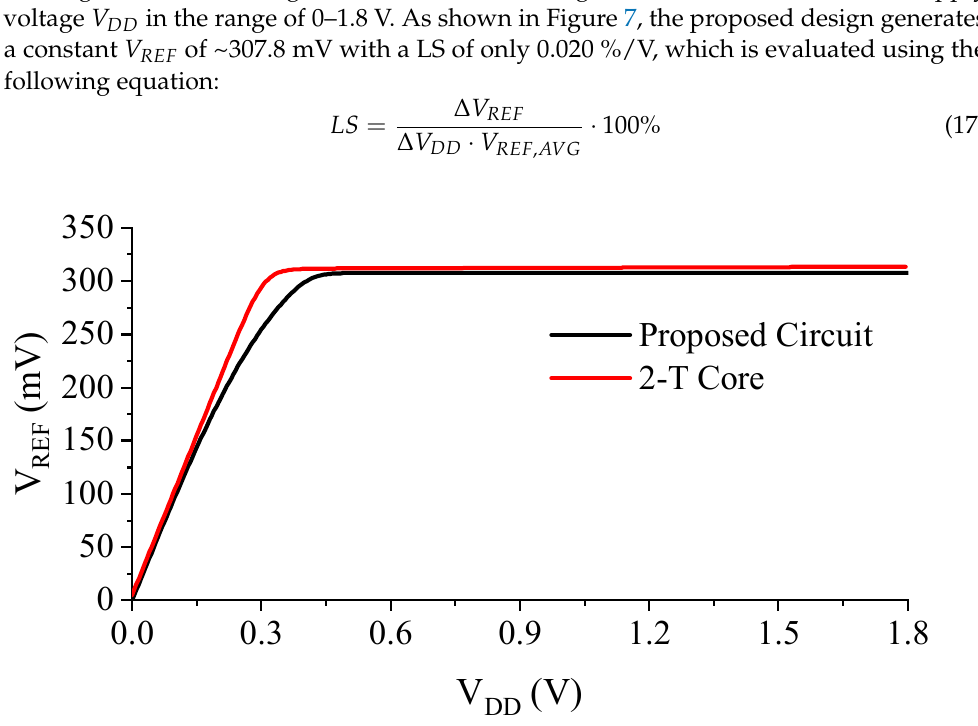
Figure 8. Simulated output voltage of the proposed voltage reference in comparison with the conventional 2-T reference.